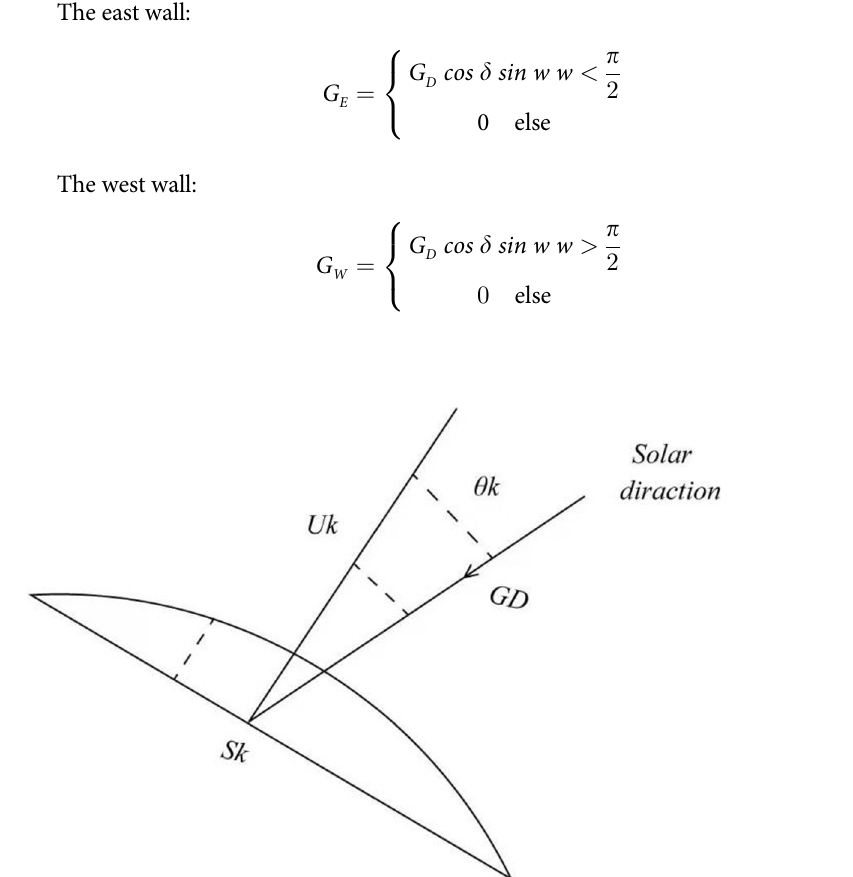
Fig 8. Incident solar radiation